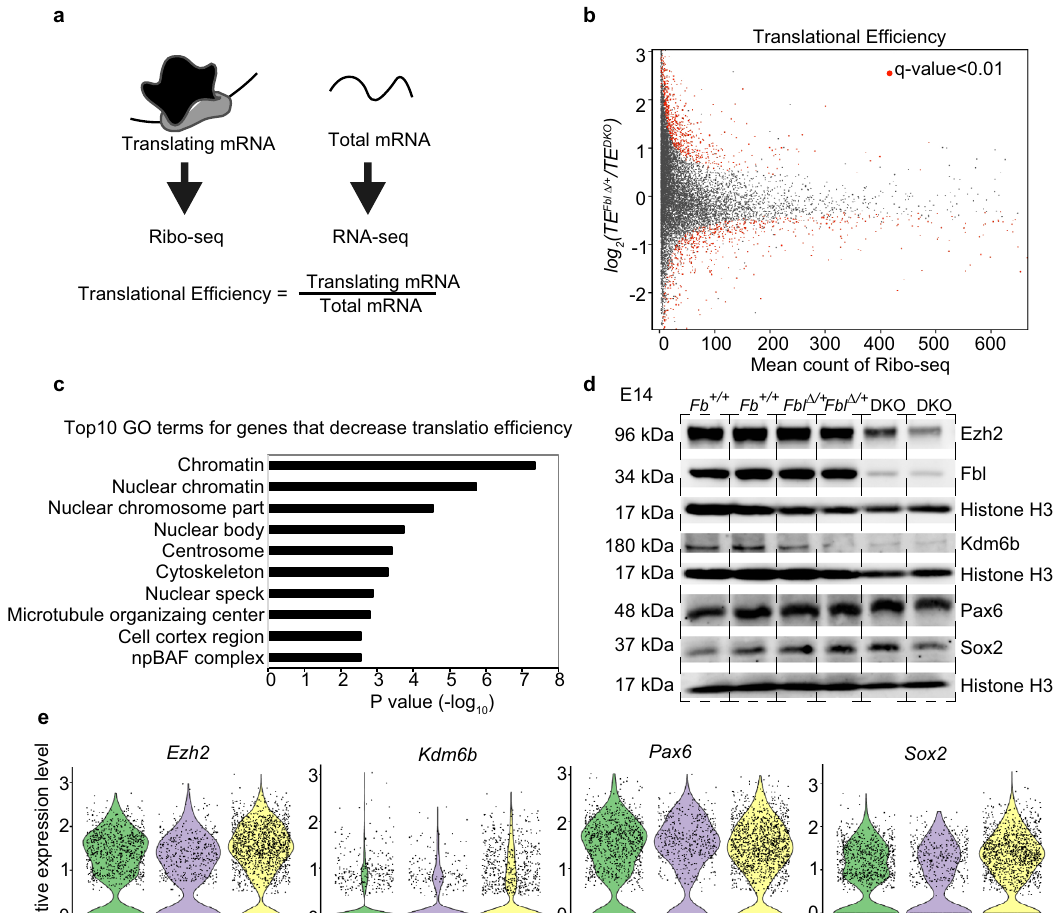
Fig. 5 Fbl selectively regulates the translation of genes involved in H3K27me3 modi fi cation. a Schematics of the experimental design for evaluation of translational ef fi ciency (TE). b Mean-count and mean-difference plots comparing the observed and expected variance in TE. Genes with q -value < 0.01 are shown in red. c Top ten GO terms of transcripts showing reduced TE. d , e Western blotting ( d ) and single-cell RNA analysis ( e ) of the indicated genes, showing reduced protein levels, but not mRNA levels, of Ezh2 and Kdm6b in DKO brains at E14. Notice that Sox2 and Pax6 did not show changes in neither protein nor mRNA